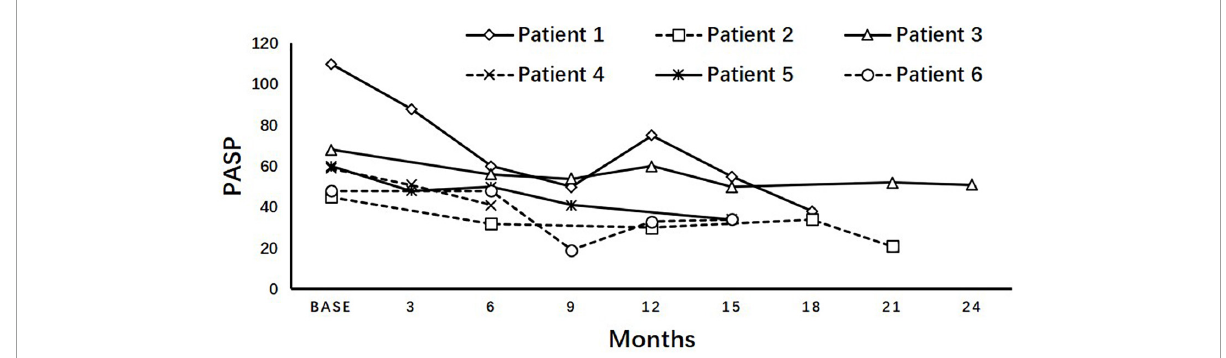
FIGURE4 Variation of PASP after reducing dose. Longitudinal pulmonary artery systolic pressure (PASP) after reducing dasatinib dosage in asymptomatic patients diagnosed with high probability of pulmonary hypertension showed an inclination of decreasing without deteriorating the treatment response, but not all of them can fully return to < 40